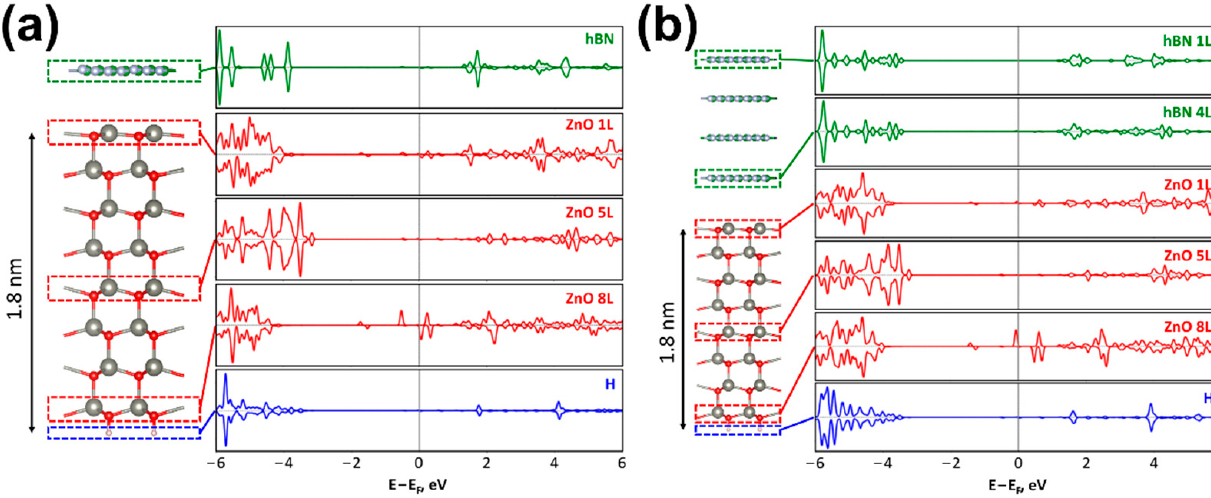
Figure 7. 1L- h -BN/ w ZnO ( a ) and 4L- h -BN/ w ZnO ( b ) heterostructures and corresponding densities of states. Red, large grey, small grey, green, and pink cycles show oxygen, zinc, boron, nitrogen, and hydrogen atoms.